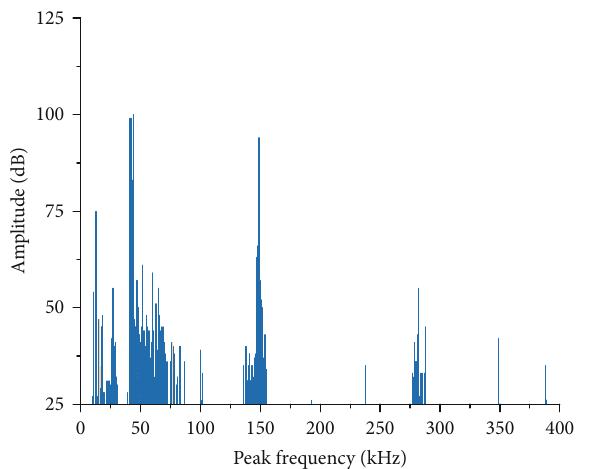
Figure 7: Distribution of amplitude with peak frequency. There are three concentrated sub-ranges in the range 0-48 kHz.